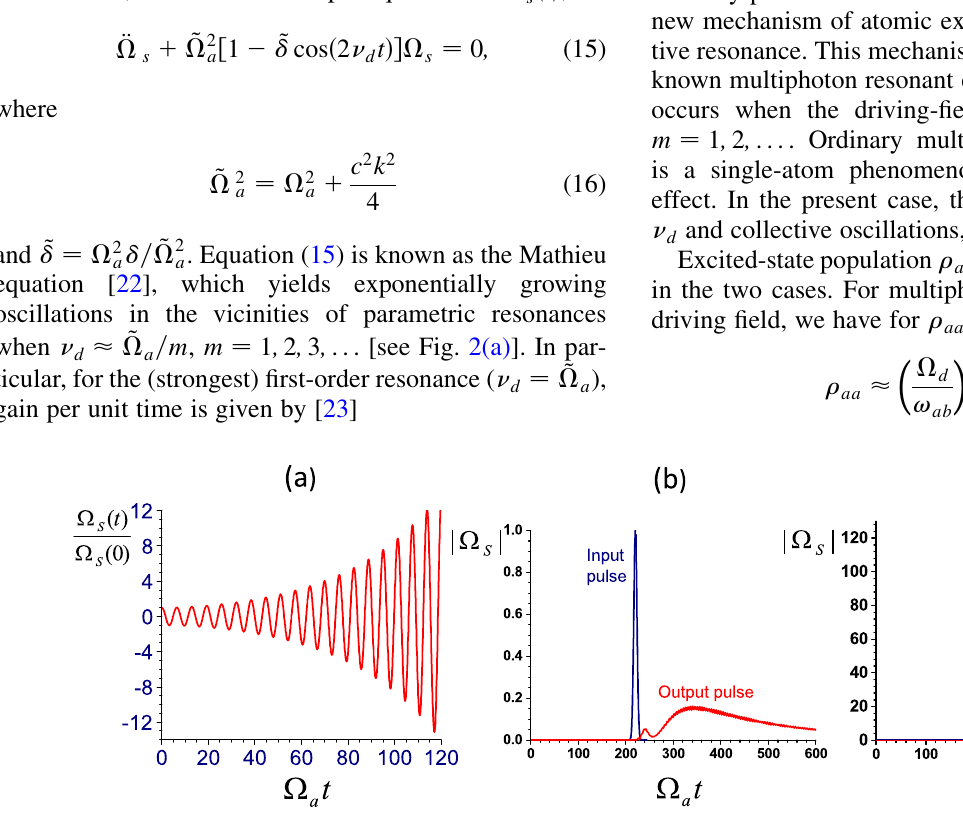
FIG. 2. (a) Superradiant field as a function of time, obtained by numerical solution of Eq. (15) with _ (cid:4) ð 0 Þ ¼ 0 . (b) Input and output superradiant pulse (cid:4) as a function of time after it propagates through the sample of length condition l s L ¼ 100 c= (cid:4) . Atoms are driven by the electric field with Rabi frequency (26) and by the magnetic field (33), which compensates the a atomic Stark shift. The superradiant pulse is sent in the same direction as the driving field. Plots are obtained by numerical solution of ¼ 5 : 2 (cid:3) ¼ 0 : 64(cid:4) ¼ (cid:4) , (cid:3) , and (cid:4) . Units of (cid:4) are arbitrary. (c) The same as in Fig. 2(b) but for the Eqs. (B65)–(B69), with ! ab d d a d a s backward-propagating superradiant